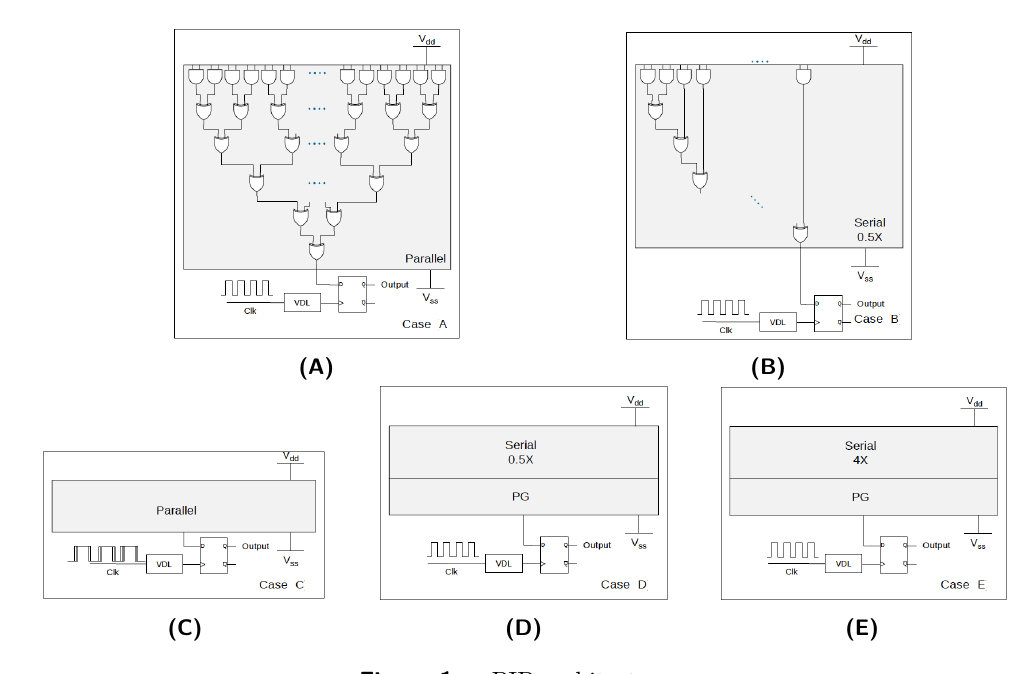
Figure 1: (cid:15) -PIP